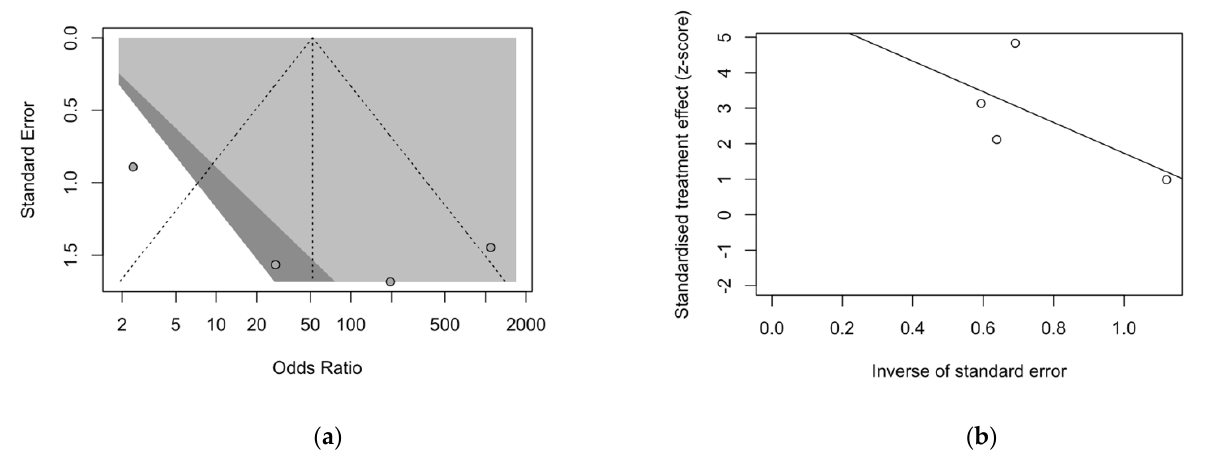
Figure 7. Funnel plots for DOR studies included in the metanalysis ( a ). Visual inspection of funnel plot suggested a significant asymmetry for all analyses, with subsequent reporting bias. Visual inspection of radial plot suggests a seemingly random distribution of included studies on both sides of the regression line. As otherwise suggested by radial plot ( b ) regression analysis dismissed a significant reporting bias ( t = 2.11, df = 2, p -value = 0.1689).